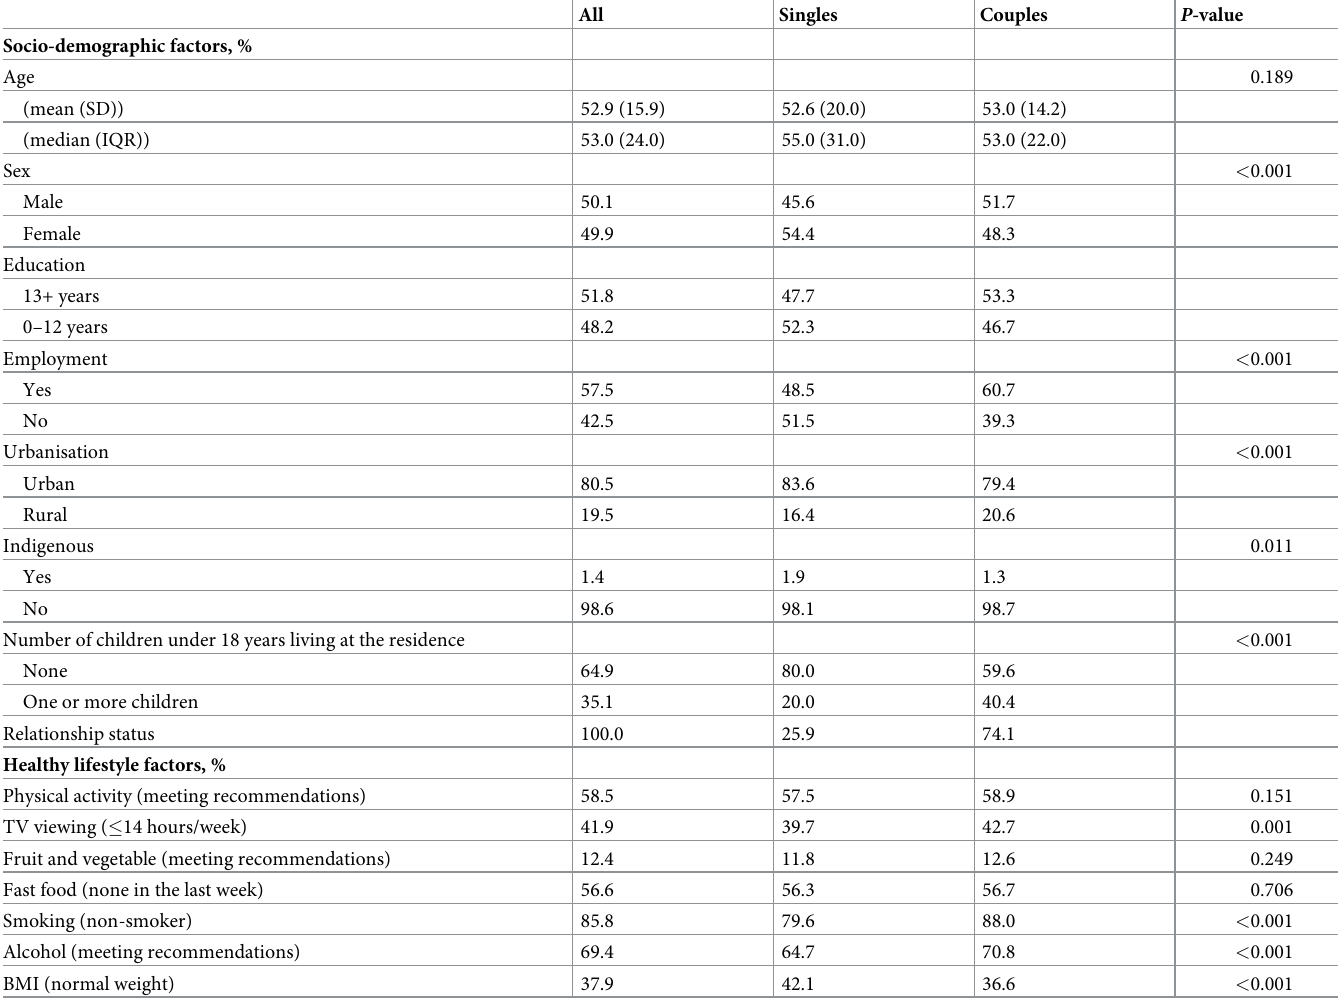
Table 1. Descriptive statistics of the sample (N = 15,001).